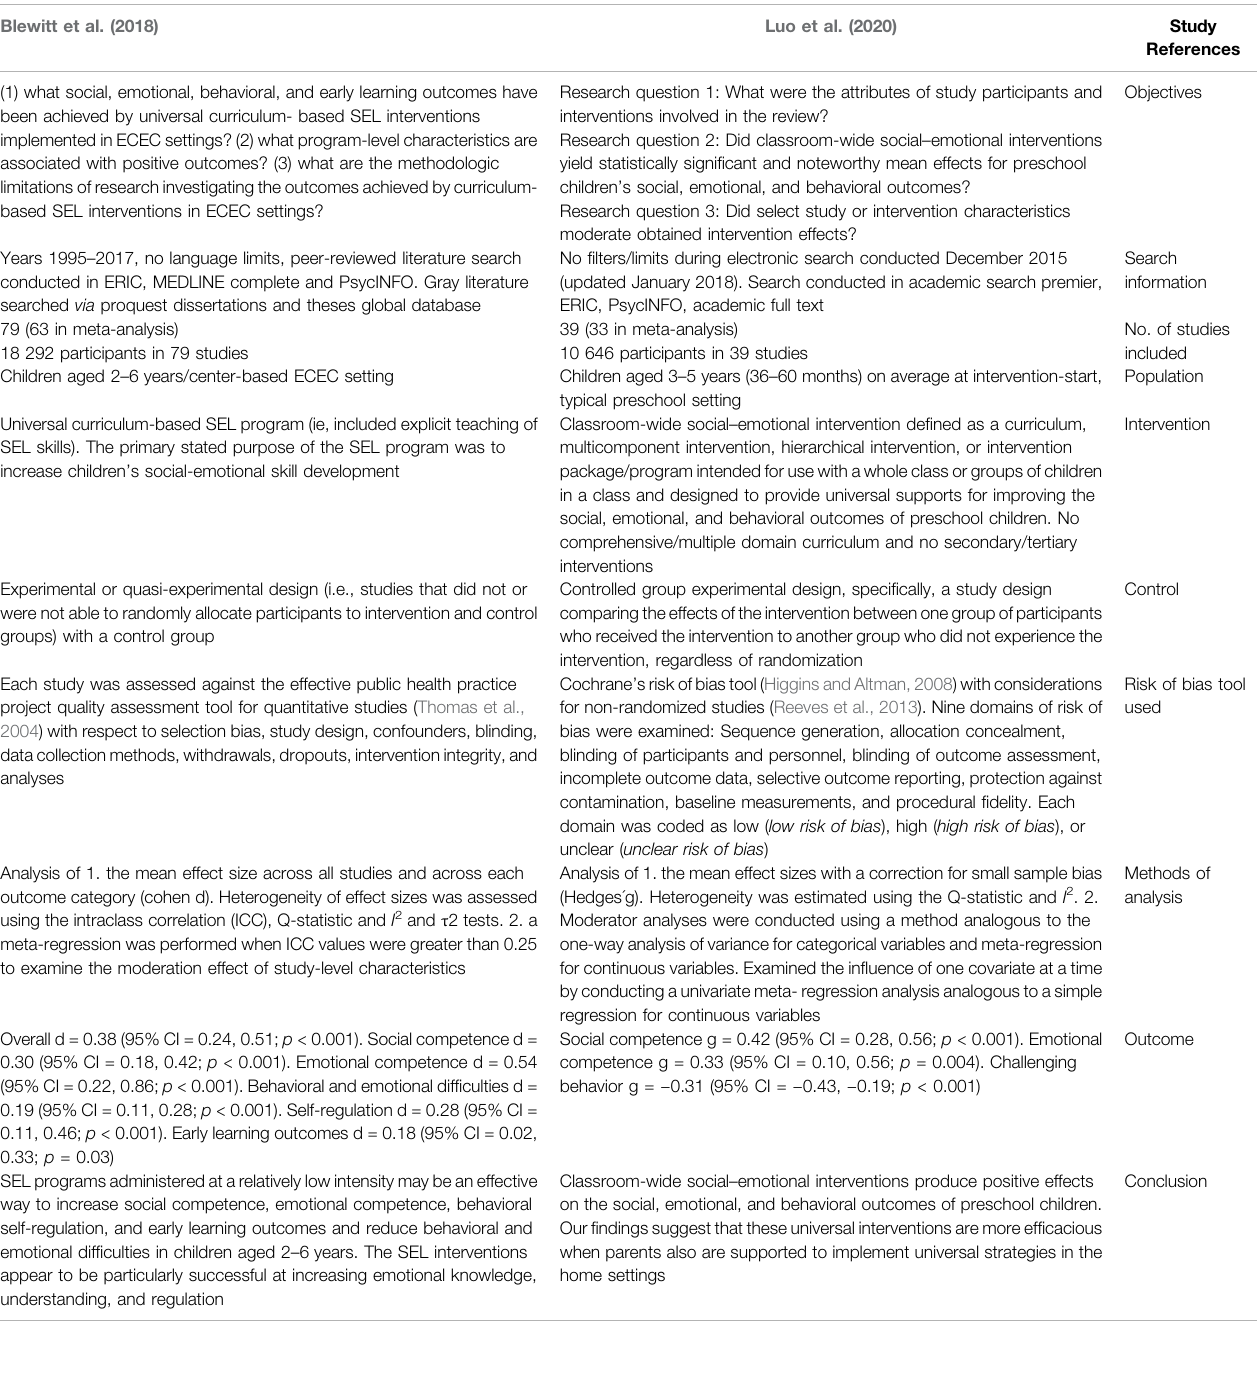
TABLE 1 | Study characteristics of included